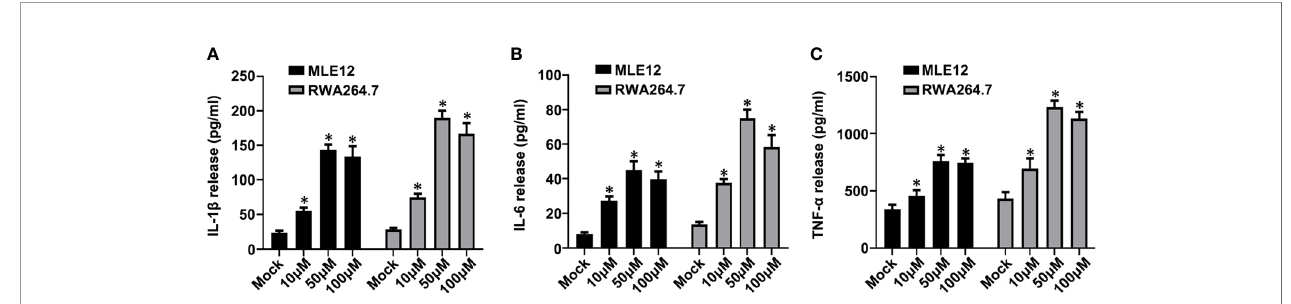
FIGURE 9 | Carbachol facilitates in fl ammatory response in lung epithelial cells and macrophage. (A – C) Levels of IL-1 b (A) , IL-6 (B) and TNF- a (C) in MLE12 and RAW264.7 cell supernatants. Data are expressed as means ± SD from 3 independent experiments. * P < 0.05 vs . Mock